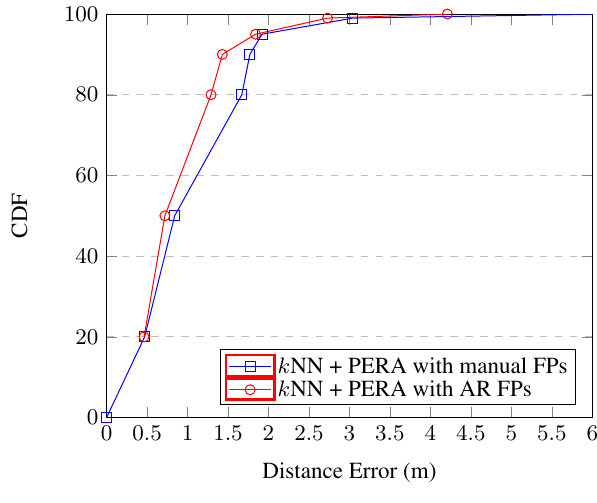
Figure 10. k NN + PERA results